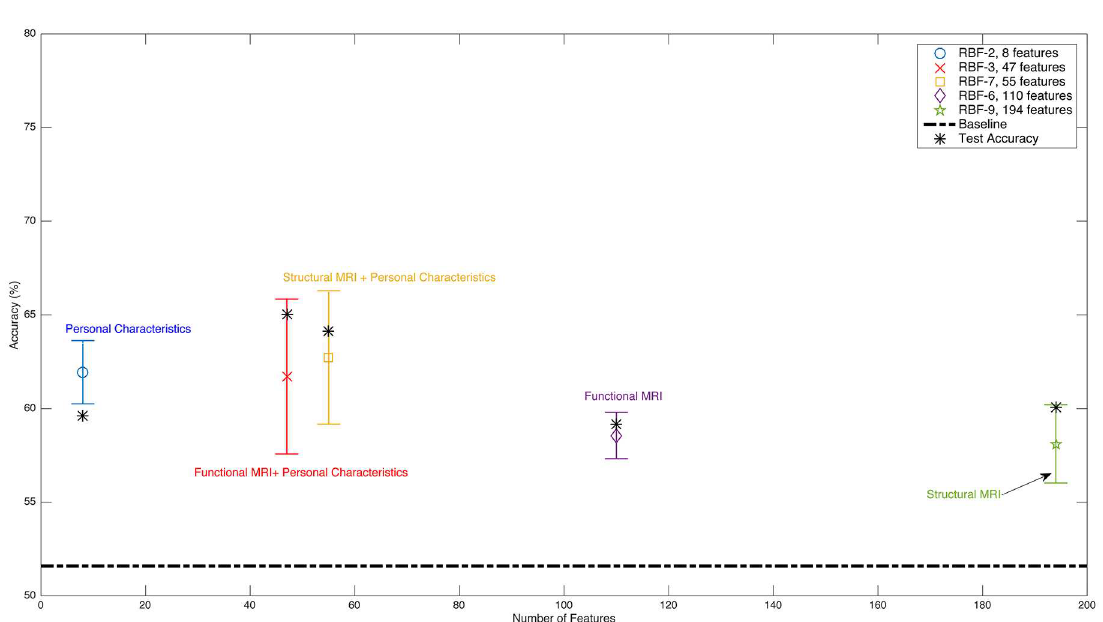
Fig 8. Summary of ABIDE dataset classification results. Conventionsare the same as for Fig 7. This figure is best viewedin